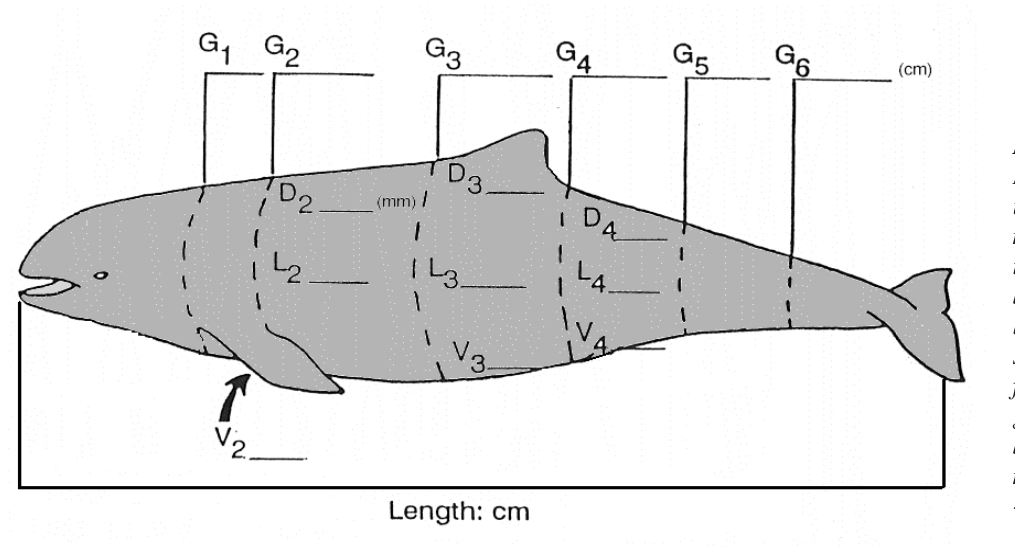
Diagram show- ing the sites of measurement on the porpoise body: total body length from snout tip to tail fluke notch; girths (G 1 – G 6 ); blubber thick- ness (D 2 - D 4 , L 2 - L 4 , V 2 -V 4